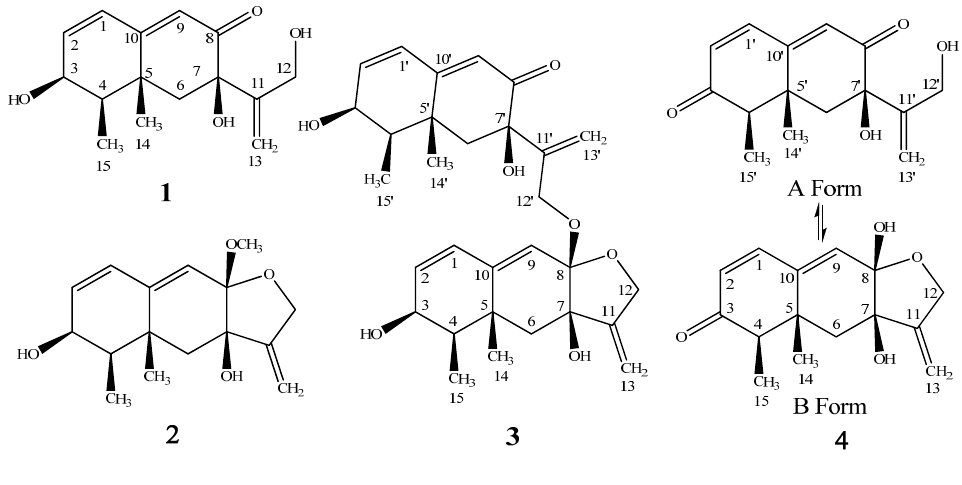
Figure 1. Structures of 1 , 2 , 3 , and 4 .